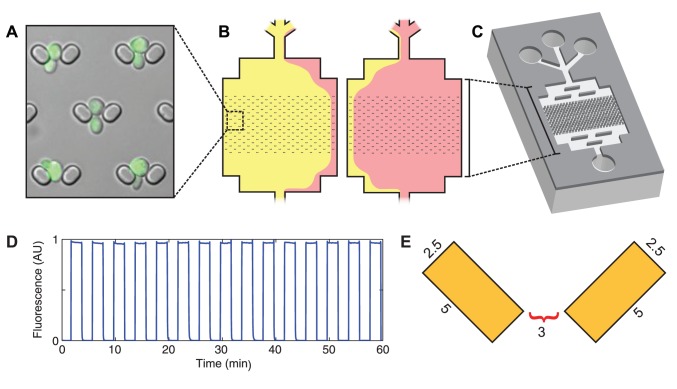
Overview of ALCATRAS.A) A DIC image of the cell traps. The cells are expressing Doa1p-GFP, and the fluorescence image has been overlaid with the DIC image for clarity. Traps consist of two vertical pillars that trap mother cells and allow daughters to flow away. The small size of the traps permits a high density of cells in the field of view (more than 40 mother cells can be imaged at 60x magnification in ALCATRAS 1). B) A schematic depicting fluid flow in the flow cell during media switching. Switching occurs within six seconds by changing the flow rate of syringe pumps. C) Overview of the microfluidic device. Each device contains more than 1500 individual traps. D) The switching rate and reliability of media switching in traps. Media switching was assayed using 0.1% fluorescein in one of the two media. E) Schematic showing trap dimensions in microns.